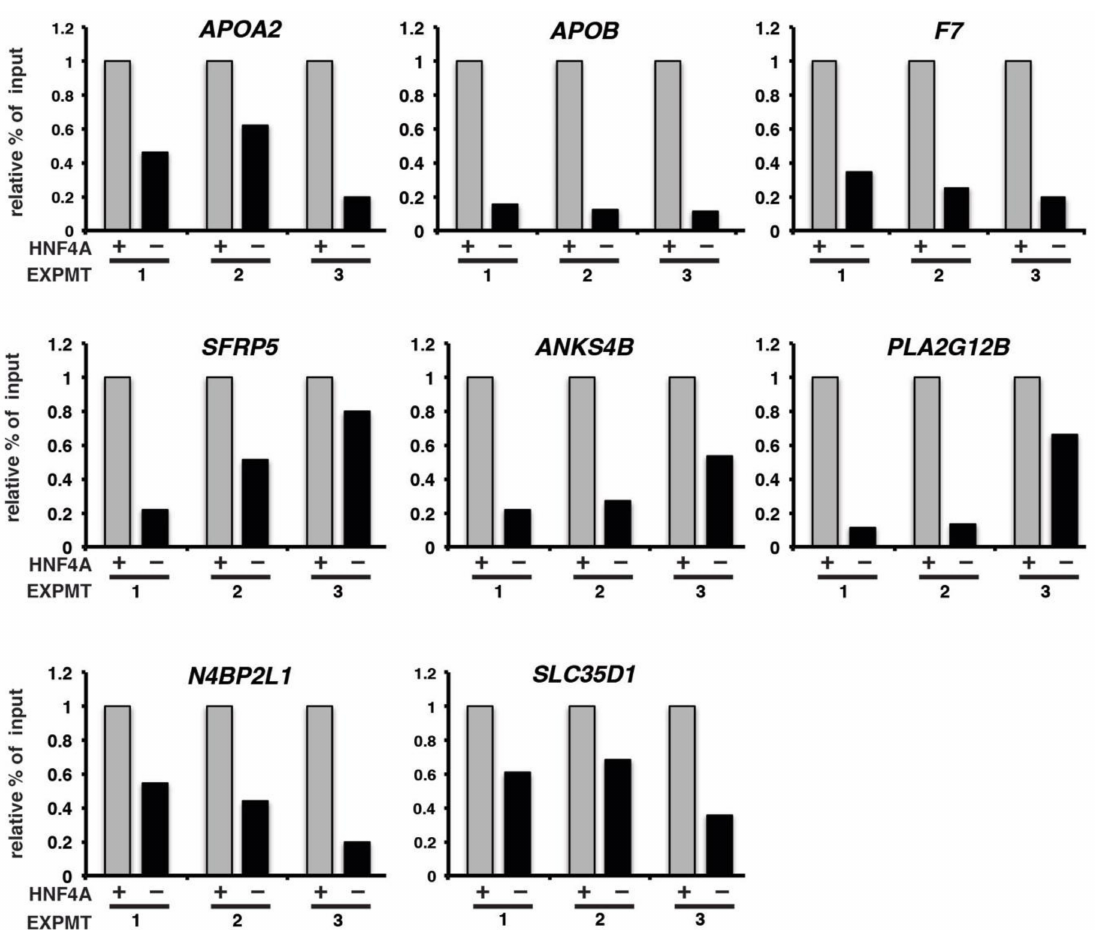
Figure 7. Recruitment of RNA pol II is decreased at HNF4A target genes when HNF4A is depleted. Bar graph showing the results of ChIP-qPCR analysis of RNA pol II occupancy of HNF4A target genes at the onset of HNF4A expression (day 8) in control and HNF4A-depleted